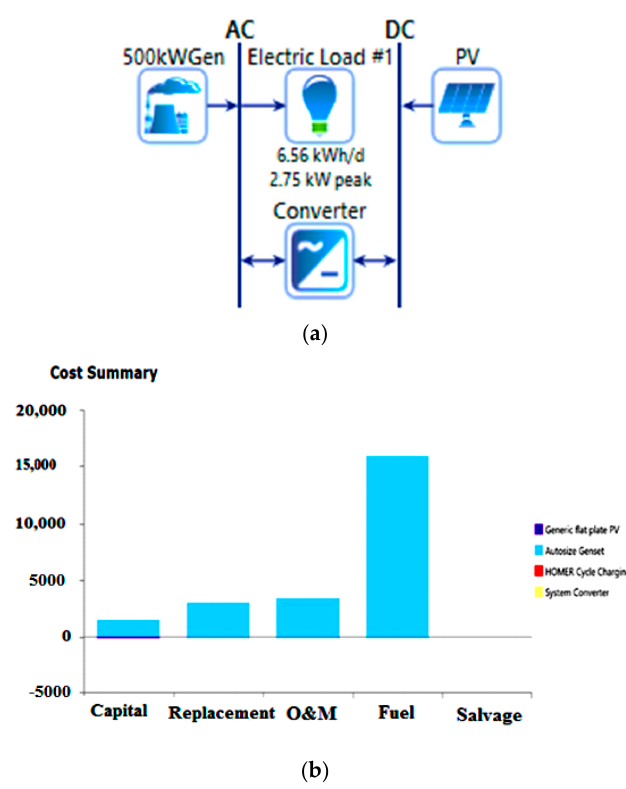
Figure 8. ( a ) Hybrid energy system with diesel generator; ( b ) Cost summary.